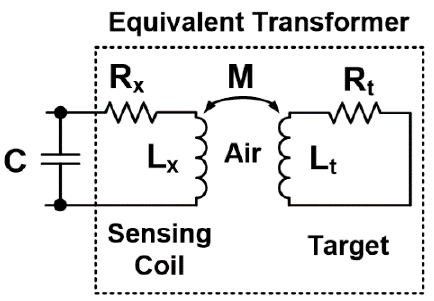
Figure 2. Equivalent transformer model and circuit of air coupling between sensing coil and target. The capacitor in the primary side is for the implementation of the LC-tank needed to generate the alternating magnetic field.